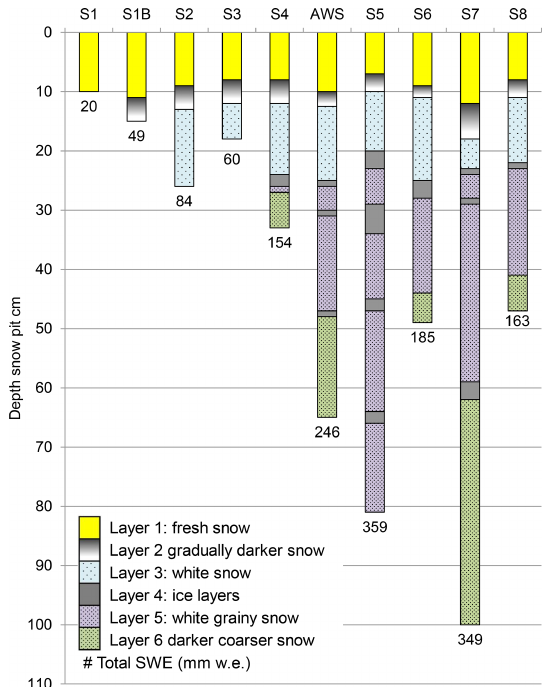
Figure 6. Snow profiles measured at the stakes on Yala Glacier on 23, 24 and 25 April 2017. At the site AWS, a temporary weather sta- tion was set up near stake S4. Distinct snow layers can be identified at all measurement sites. At the stakes S5, S6, S7 and S8 sawdust from 19 and 20 November 2016 was found at the bottom of the snow pit, and glacier ice was found at all lower